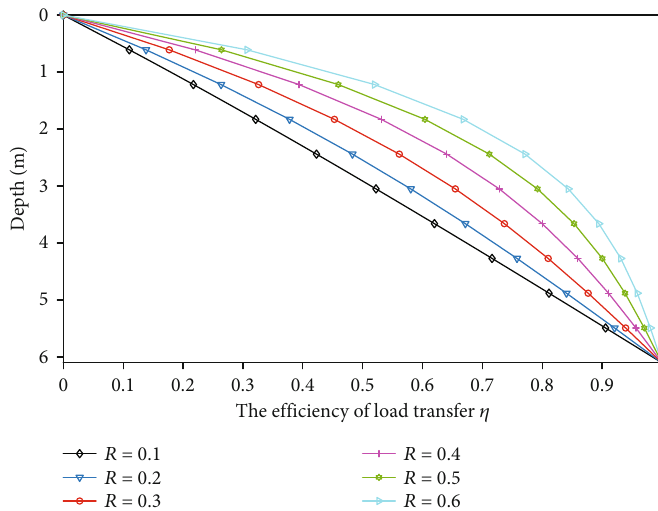
Figure 11: The in fl uence of comprehensive parameters of slope-pile R on the e ffi ciency of load transfer η